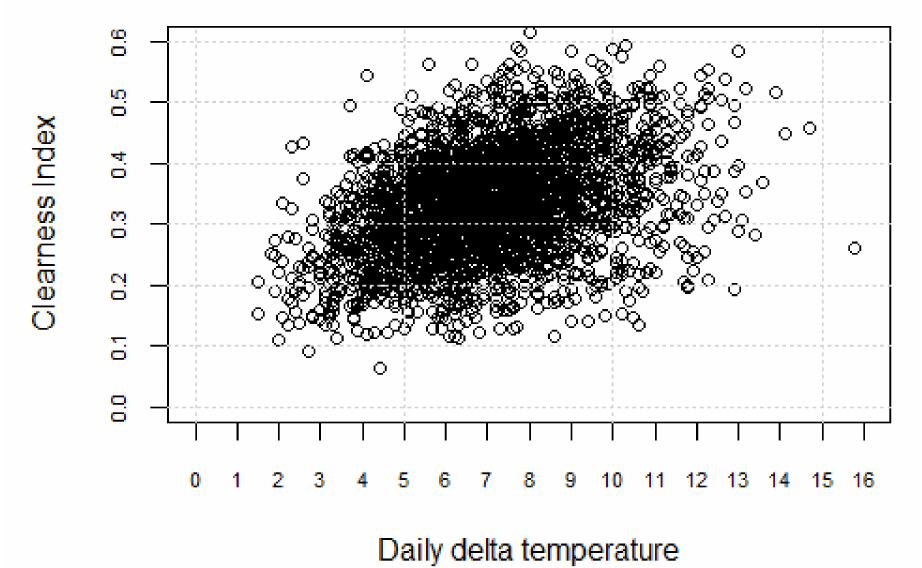
Figure 6. Daily delta of temperature–clearness index for Universidad de Nariño.